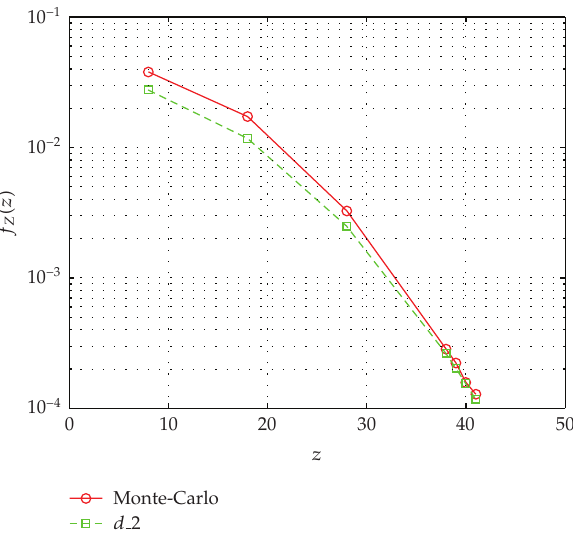
Figure 5: Right tail f Z ,ρ > σ 1 /σ 2 . d 2 is the approximation.